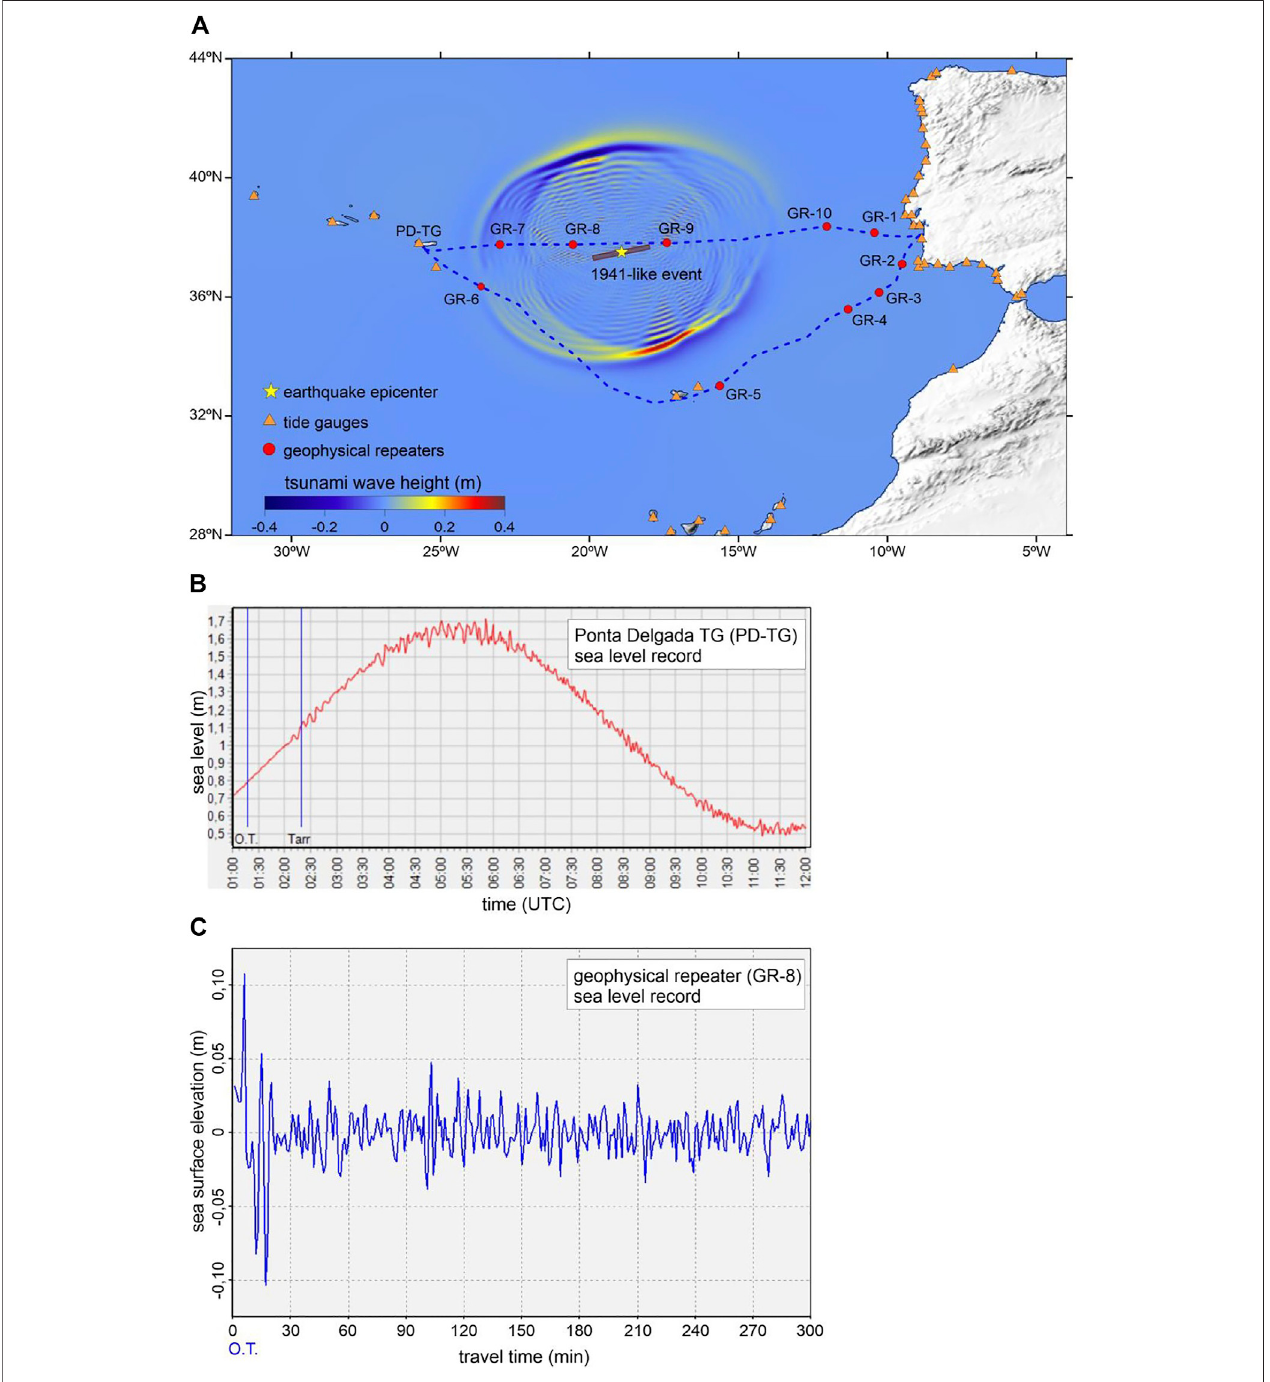
FIGURE 6 | Sea-level signal quality comparison. (A) tsunami numerical propagation for a 1941-like earthquake in the presence of cabled sensors and tide gauge stations (B) signal recorded at the Ponta Delgada tide gauge; (C) signal recorded by a cabled sensor (GR-8 in a). OT (cid:1) earthquake origin time.